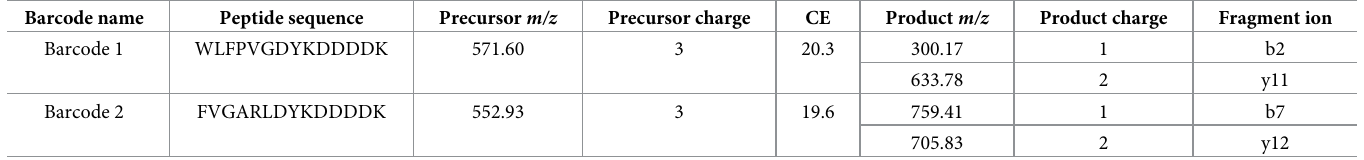
Table 2. Parameters for SRM analysis of peptide